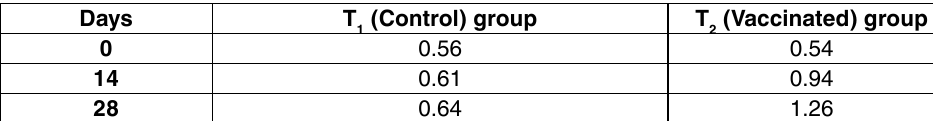
Mean values bearing different superscripts within the row differ significantly (p< 0.001) table 2. Stimulation